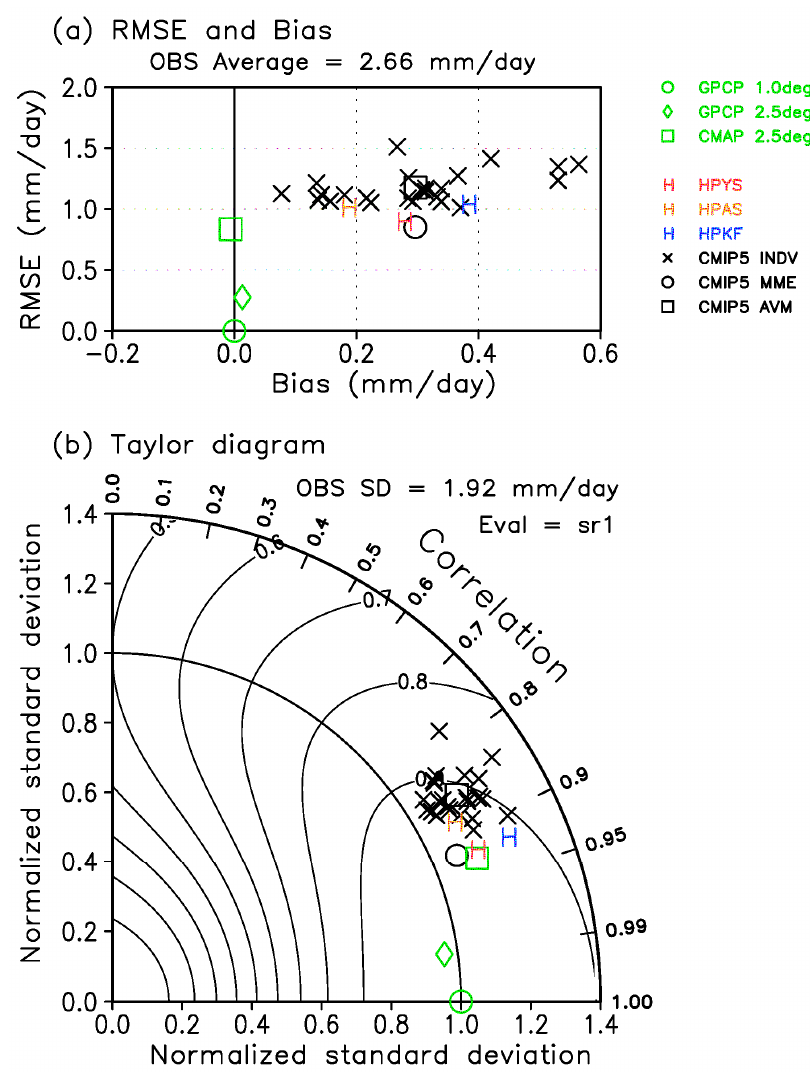
Figure 3. Skill of PAV simulated by models verified against the GPCP 1dd V1.2 data (green circle) for the global domain. Green marks denote other observations (Table 2). Color characters show the MRI-AGCM3.2H models. Red, orange and blue characters denote the YS, AS and KF schemes, respectively. Black marks X show the CMIP5 individual models. Black circles indicate the MME mean. Black squares indicate the average of the skill scores of all of the CMIP5 models (AVM). The target domain is the same as in Figure 2. ( a ) The root mean square error (RMSE) and bias (mm day − 1 ). The domain average of observation is shown above the panel. ( b ) Taylor diagram for displaying pattern statistics [40]. The standard deviation of the observation in the domain is shown above the panel. The contour shows the value of Taylor skill S .